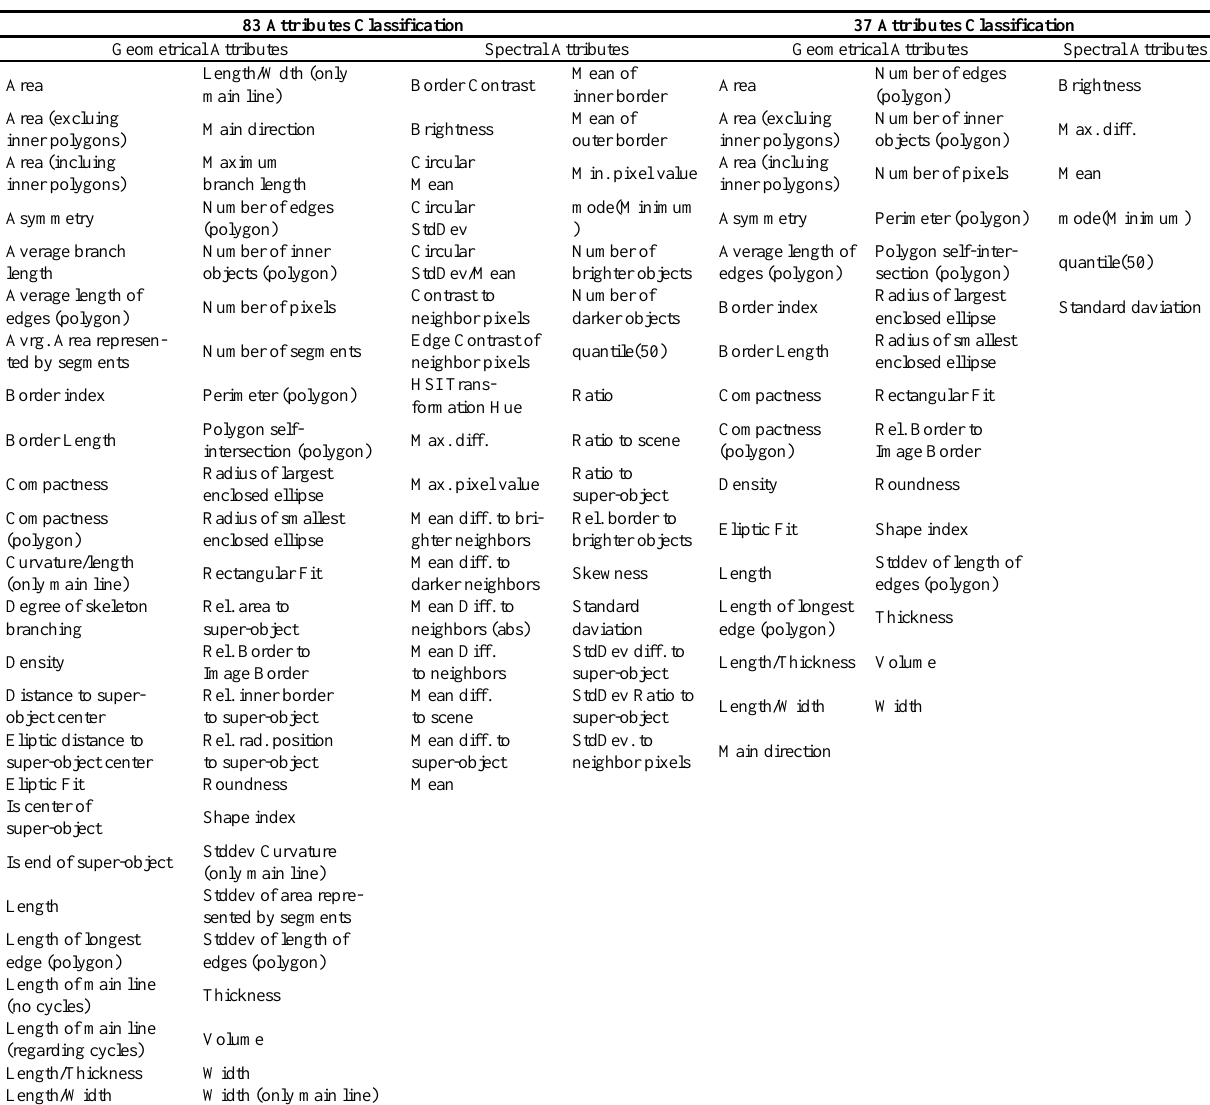
Table 2. Both geometrical and spectral attributes used in the